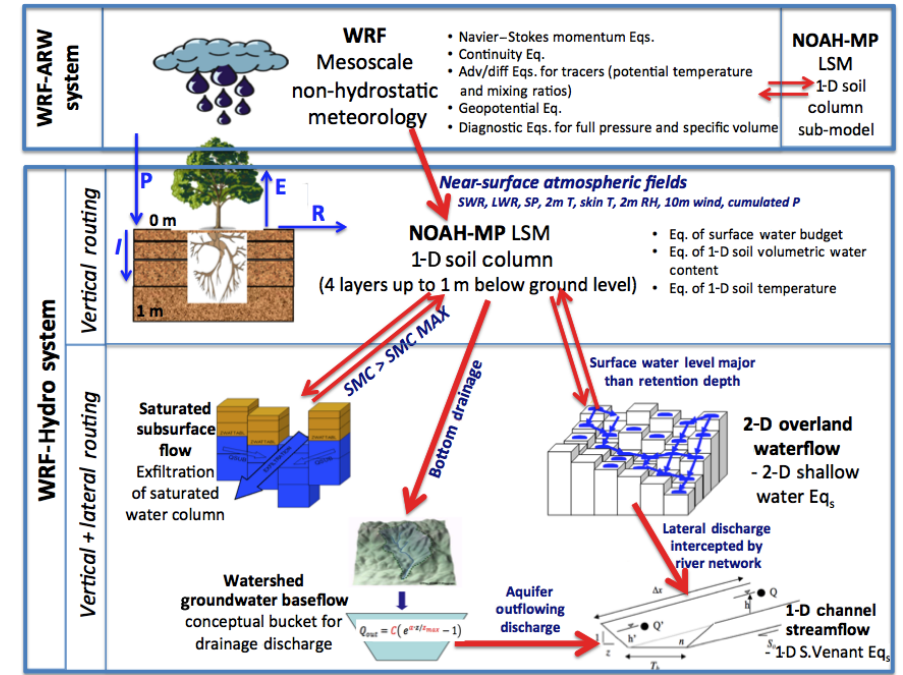
Figure 3. The meteo-hydrological modelling